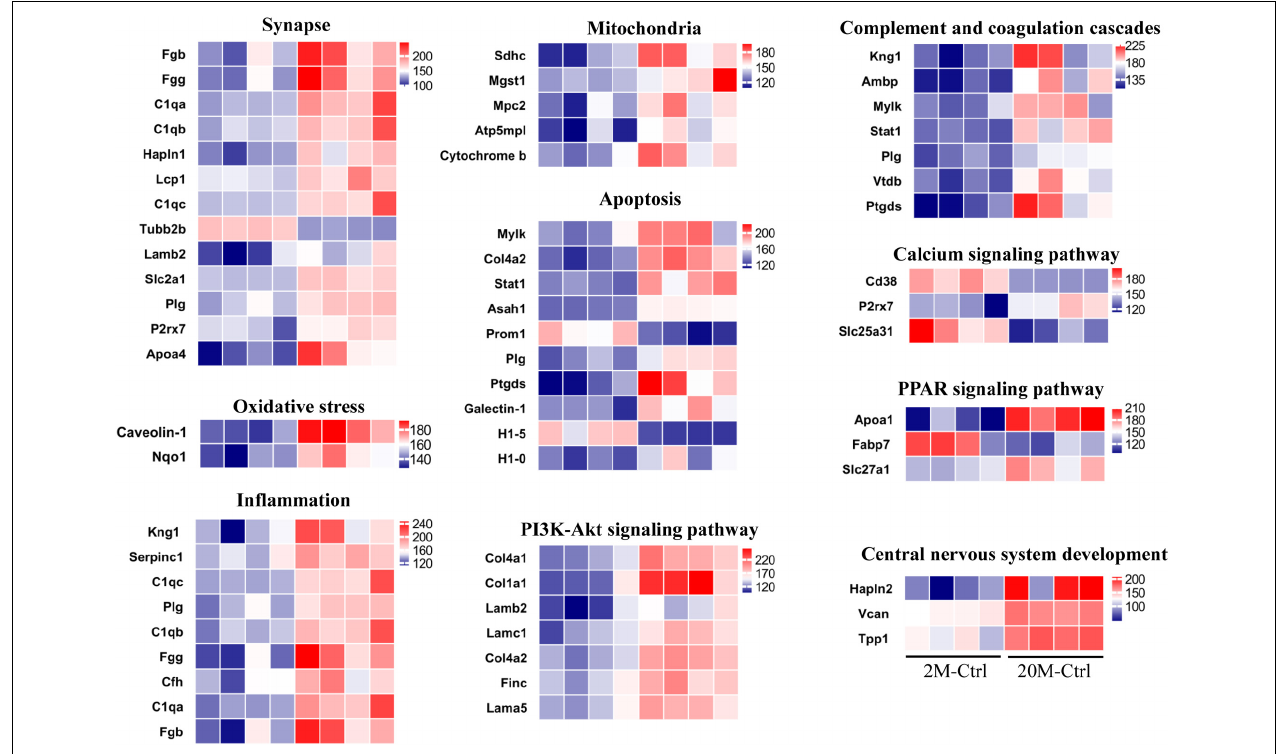
FIGURE 2 | DE hippocampal proteins in aging vs. young control mice. The aging related proteins functionally classified according to uniport database. The color of blue represented low abundance, red represented high abundance ( n = 4